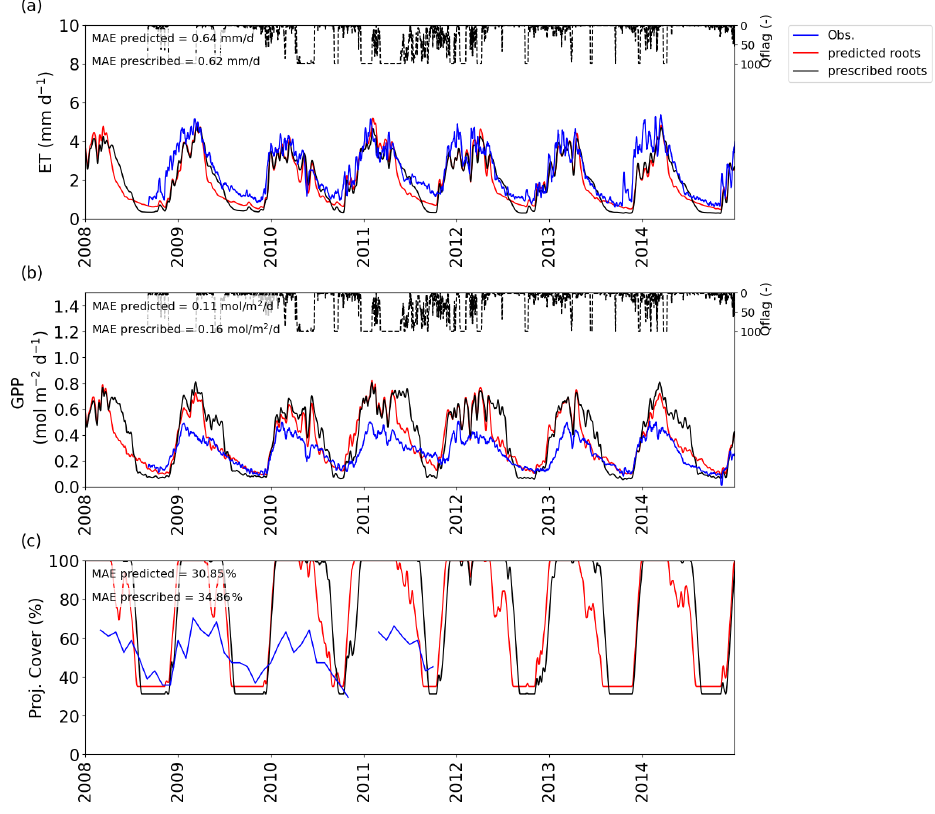
Figure 9. VOM results for prescribed (black) and predicted (red) rooting depths for Dry River for 2008–2014 (as a subset from 1980 to 2017), with (a) the ET, with flux tower observations in blue, (b) GPP, with flux tower observations in blue, and (c) projective cover, with the observed fraction of vegetation cover based on fPAR data (Donohue et al., 2013). Daily average quality flags for the flux tower observations are added on top of (a) and (b) and range from 0 (no missing values) to 100 (completely gap-filled). The time series for ET and GPP are all smoothed with a moving average with a window of